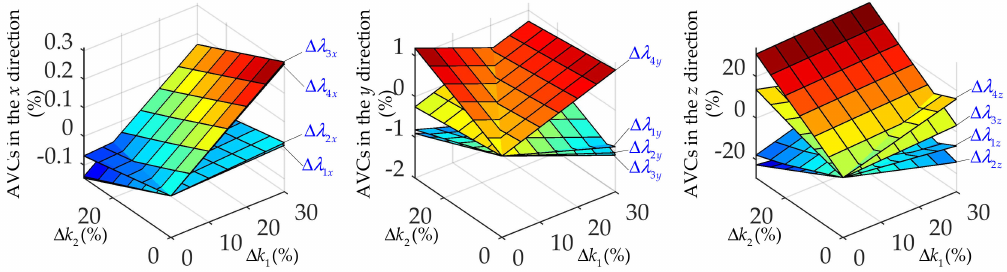
Figure 7. The amplitude variation coe ffi cient (AVC) surfaces of four spring seats in the x , y , and z